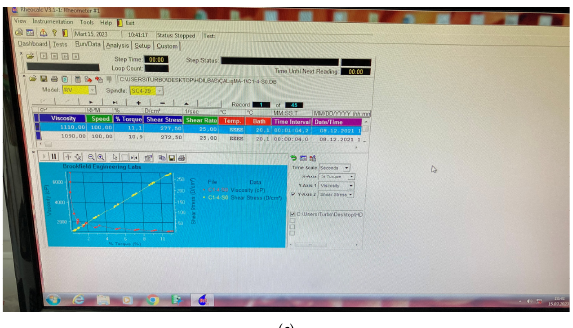
Figure 1. Test setup and details: ( a ) the rheology test, temperature regulator and testing device part with spindle and sample container; ( b , c ) data evaluation was obtained with device software.